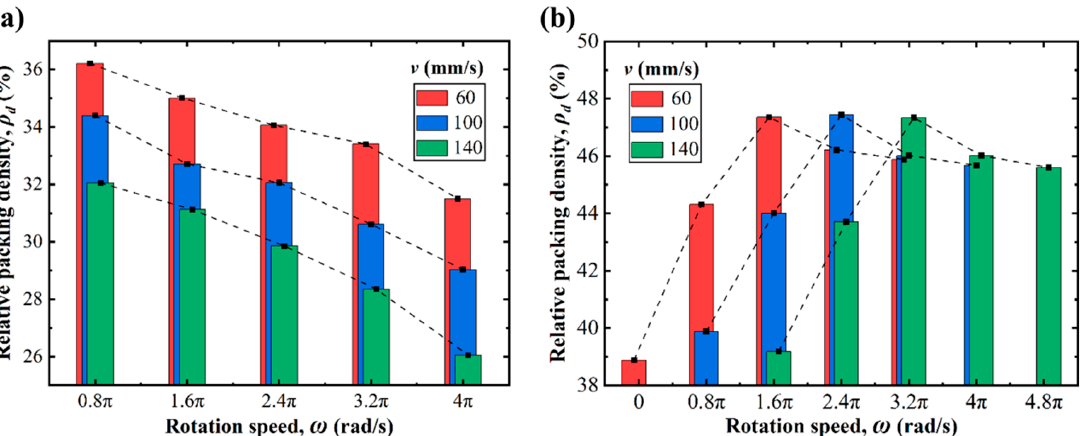
Figure 5. Evolutions of packing density with different rotation speeds and spreading speeds in a